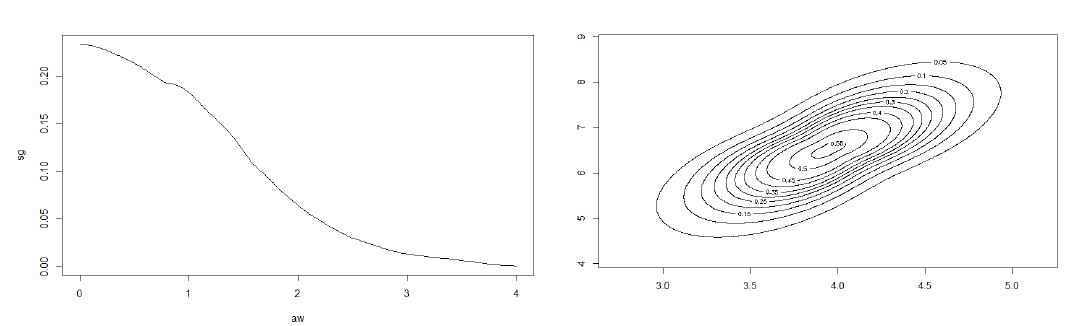
Figure 11. Estimated generator function g at left (bandwidth b = 0.5) and contour plot of ˆ ϕ at right .